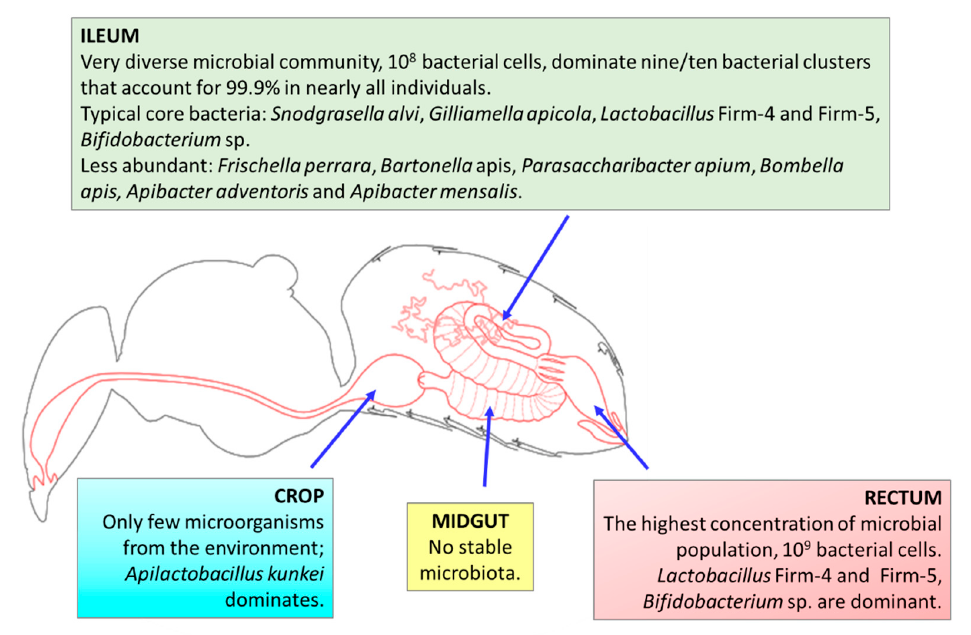
Figure 1. The gastrointestinal microbiota of an adult worker honeybee ( Apis mellifera ) (references in the text). Figure taken from http://honeybee.drawwing.org/book/crop (accessed on 22 March 2021) with the permission of the author.